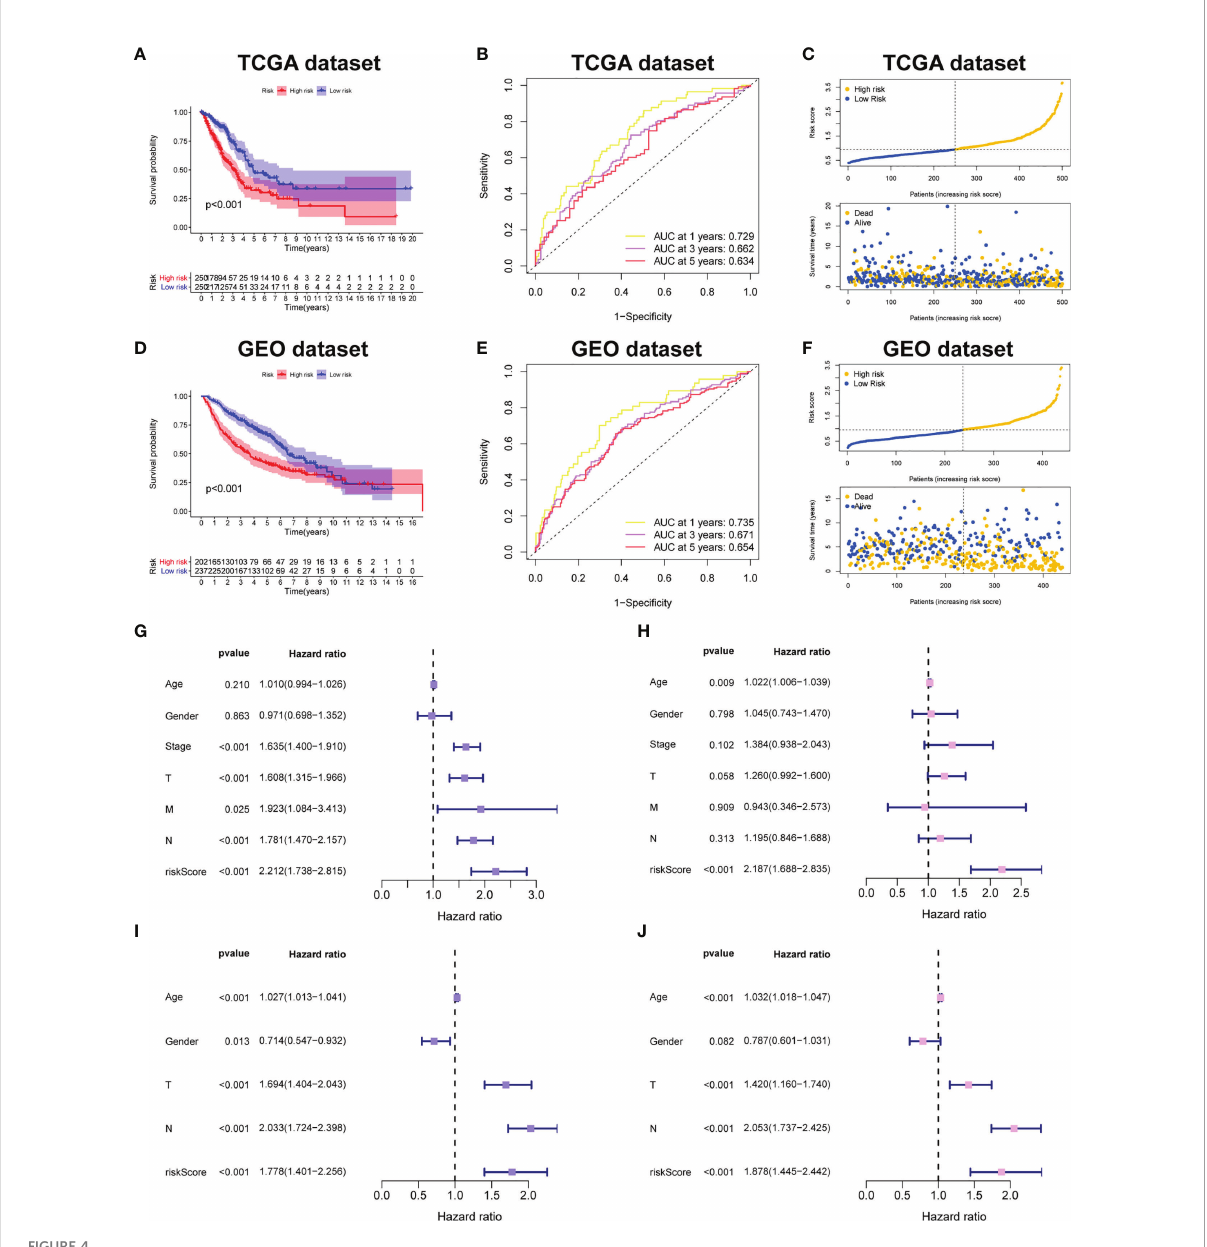
FIGURE 4 Prognostic powerful of the CRBS. (A, D) Survival analysis in the TCGA-LUAD and the GSE68465 cohorts. (B, E) ROC curves of the CRBS. (C, F) The risk distribution plots in two datasets. (G – J) Cox relevant regression assessing the independence of the